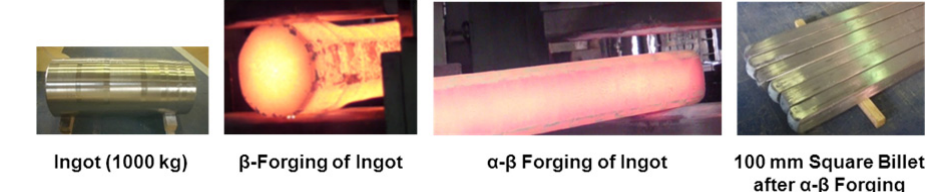
Figure 1. Ti-15Zr-4Nb-4Ta alloy B ingot and 100 mm square billets after β and α - β forgings.